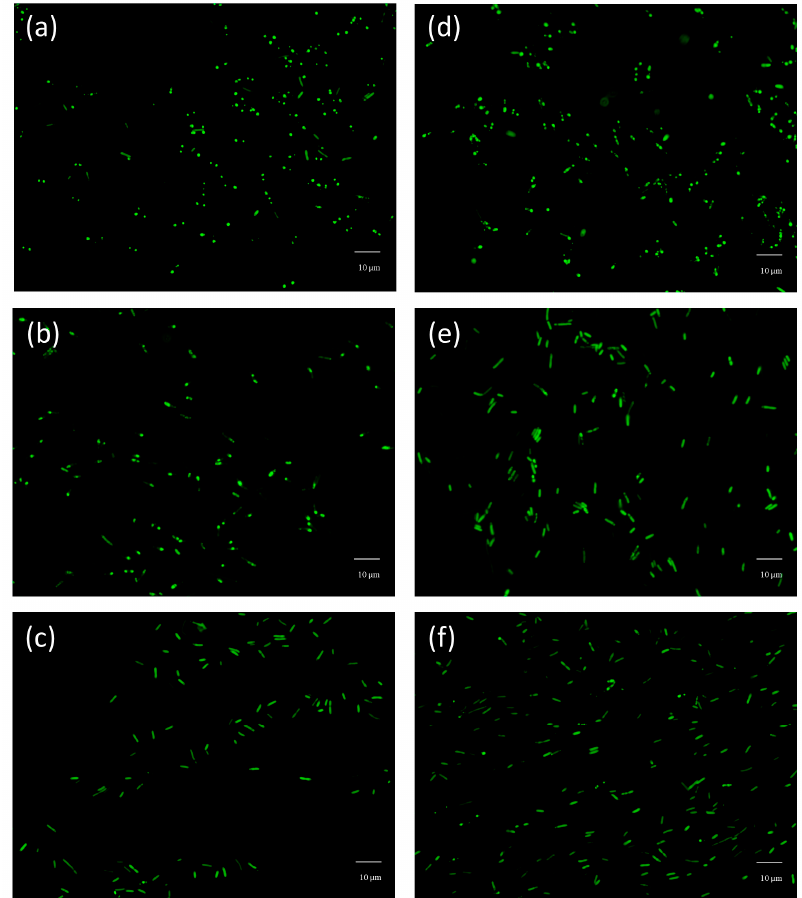
Figure 7. Fluorescence microscopy images of PET samples after incubation with bacteria: ( a ) PET untreated after 1 h; ( d ) PET NP after 1 h; ( b ) untreated PET after 4 h; ( e ) PET NP after 4 h; ( c ) untreated PET after 6 h; ( f ) PET NP after 6 h. Scale bar, 10 μ m.